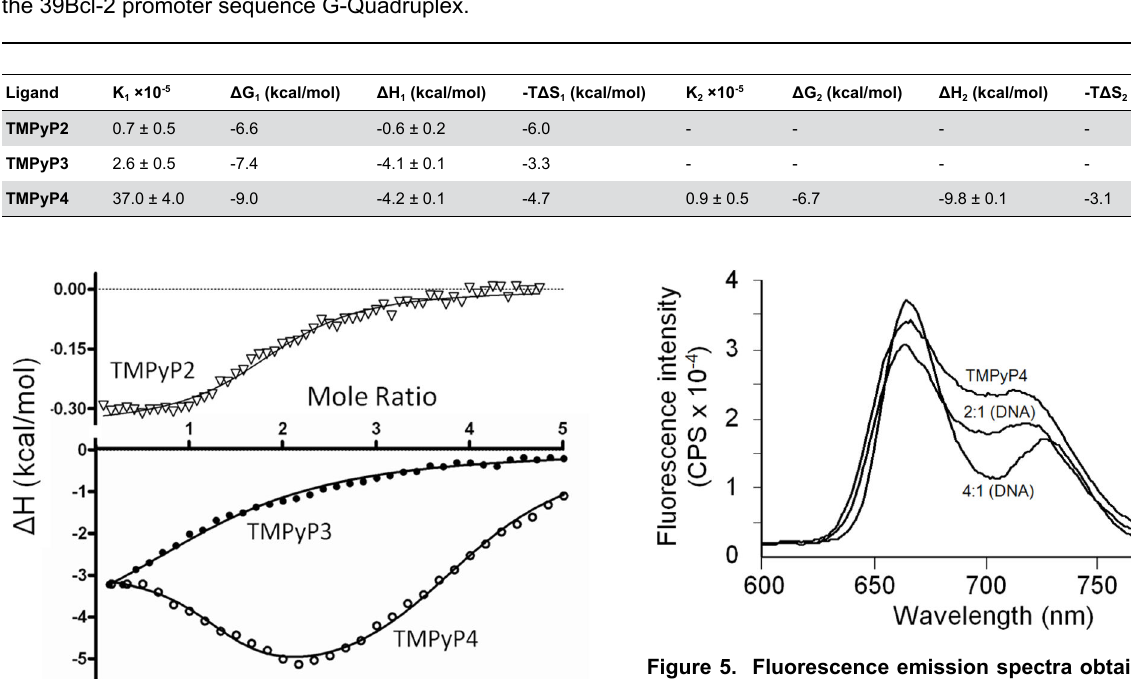
Table 1. ITC Derived Thermodynamic Parameters for the binding of porphyrin ligands (TMPyP2, TMPyP3, and TMPyP4) to the 39Bcl-2 promoter sequence